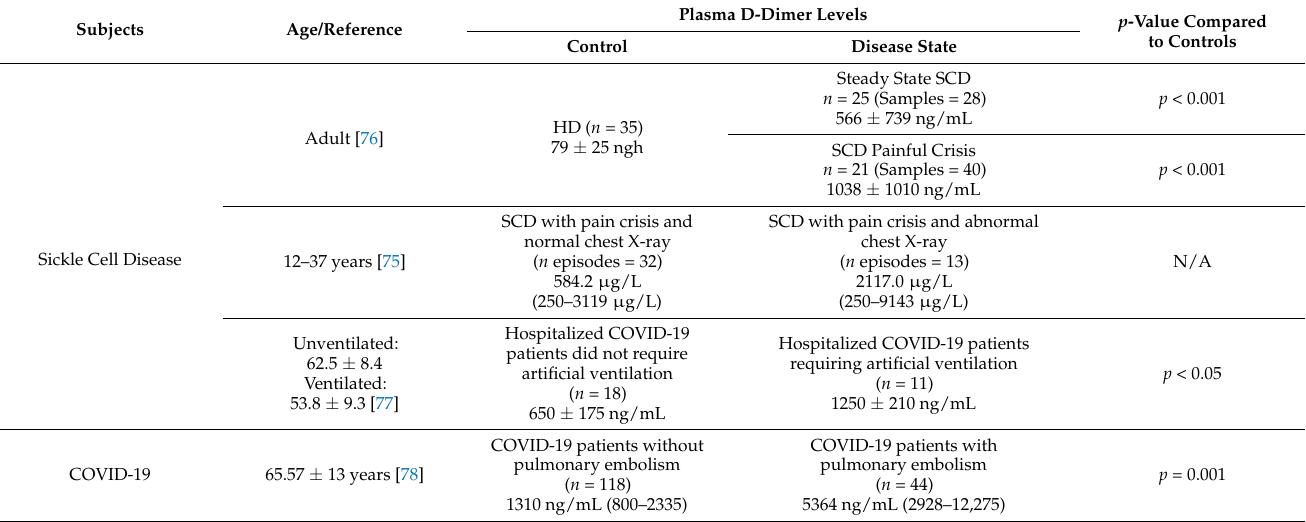
Table 1. Comparative analysis of Plasma D-dimer levels in SCD during the steady state and sickle crisis and in COVID-19